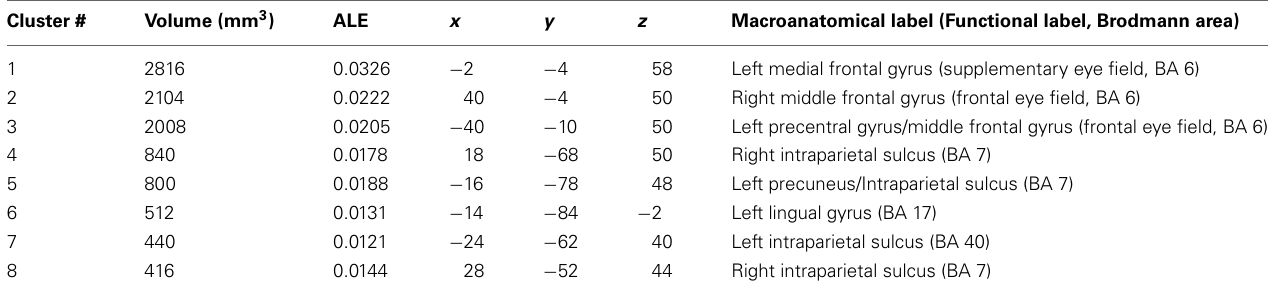
Table 3 | Talairach coordinates, volume (mm 3 ), ALE values and anatomical labels for the prosaccade > fixation analysis. Cluster #